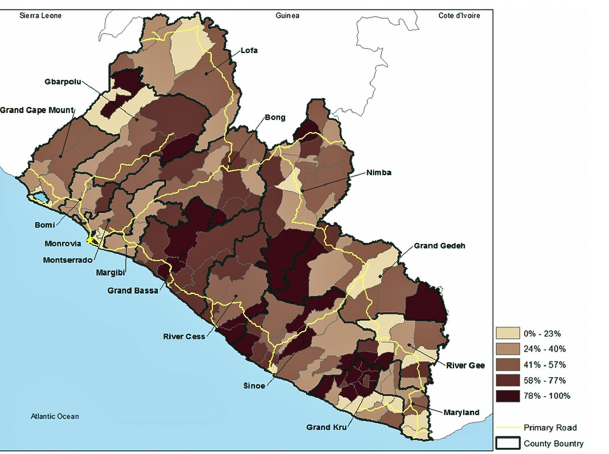
Fig 4. Percentage of households in each district that are more than 80 minutes travel to a healthcare facility. Travel by the rural population is primarily by foot, bicycle, motorbike, bush taxi, truck, or some combination. Organized public transportation is lacking and many roads are impassable in the rainy